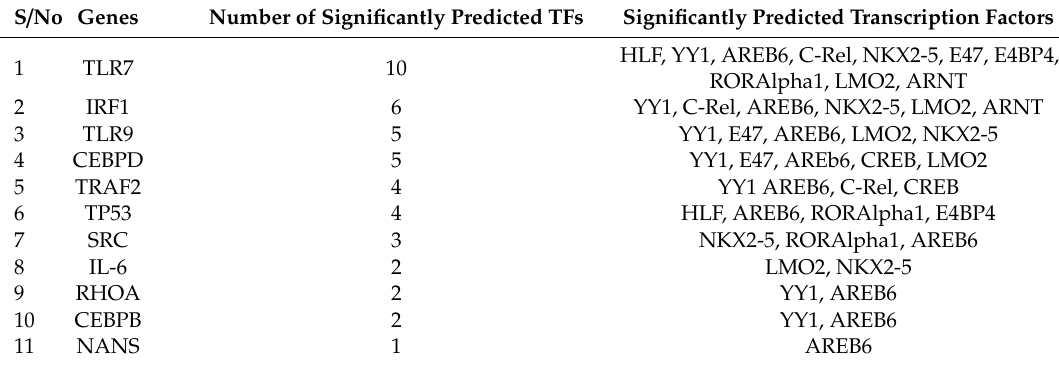
Table 2. List of significantly expressed genes during bovine coronavirus infection and the number of predicted transcription factors.